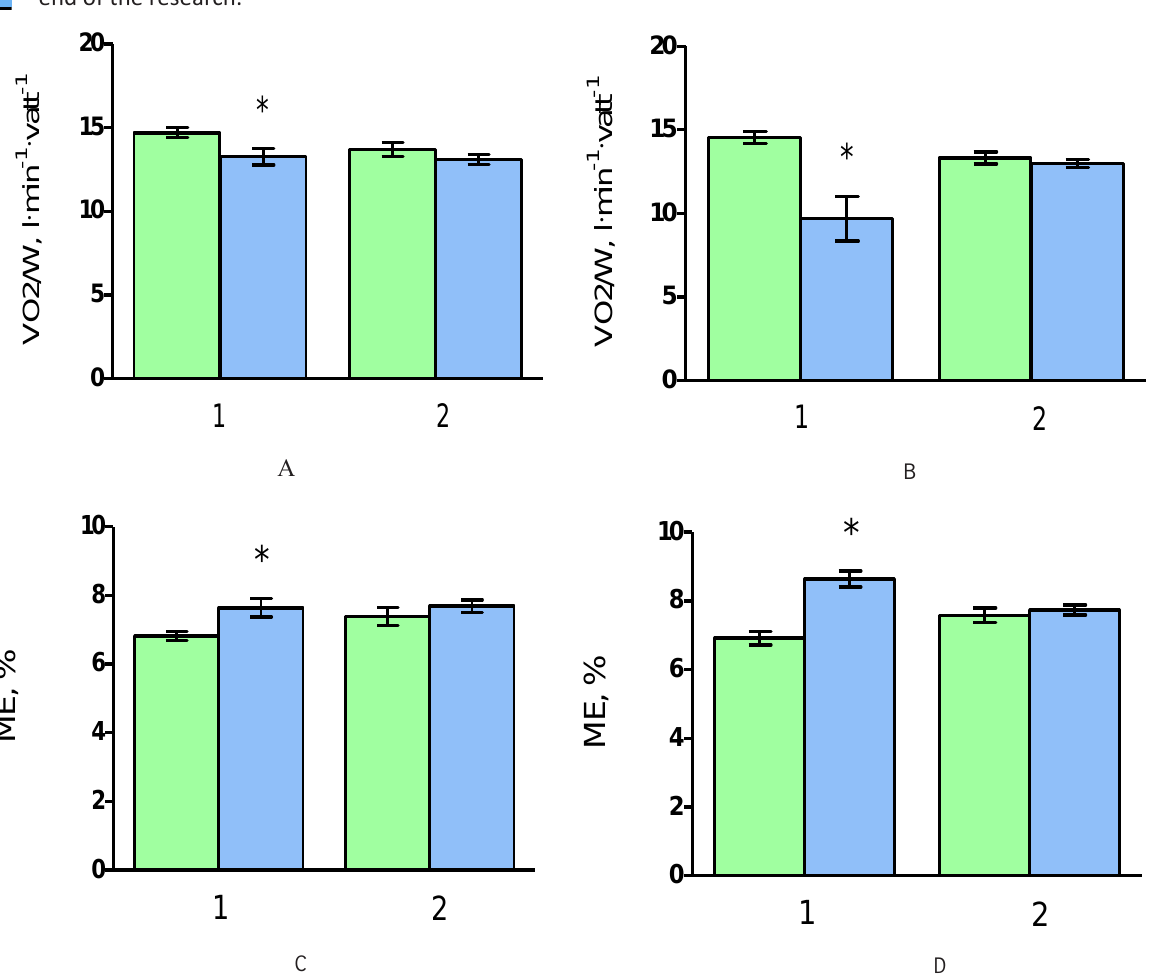
Fig. 3. Influence of “Energel. Endurance” on economy and effectiveness of test loading fulfillment on ergo meter at AnMT (A, C) and (B, D) MOC levels: 1 – experimental group; Ec– economy, економічність, Ef –effectiveness; * − p ≤ 0.05; W – power; t – time,